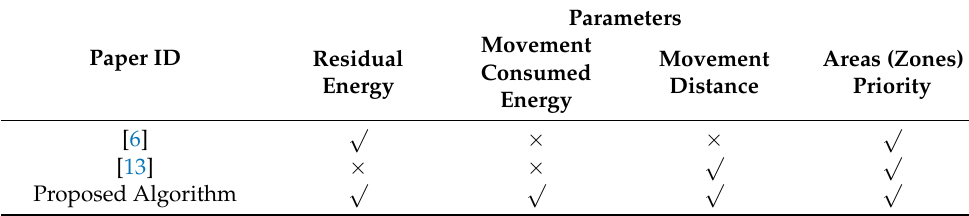
Table 1. A comparative summary of the algorithms mentioned above and the proposed